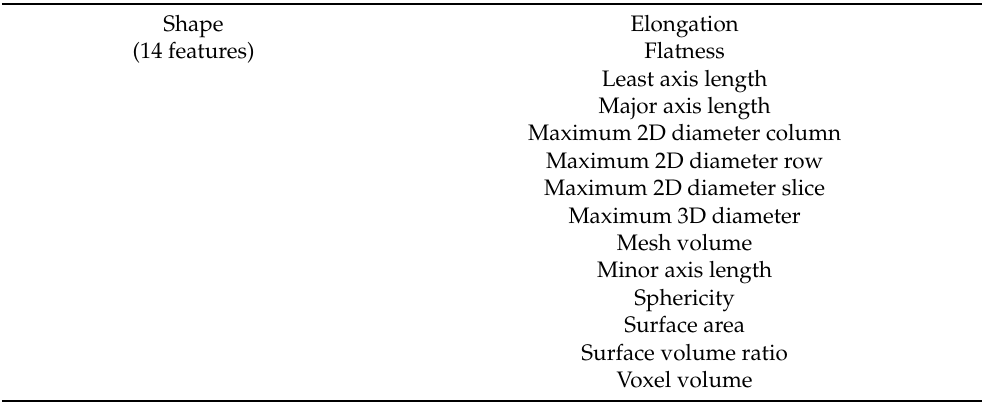
Table A1. From original image only.